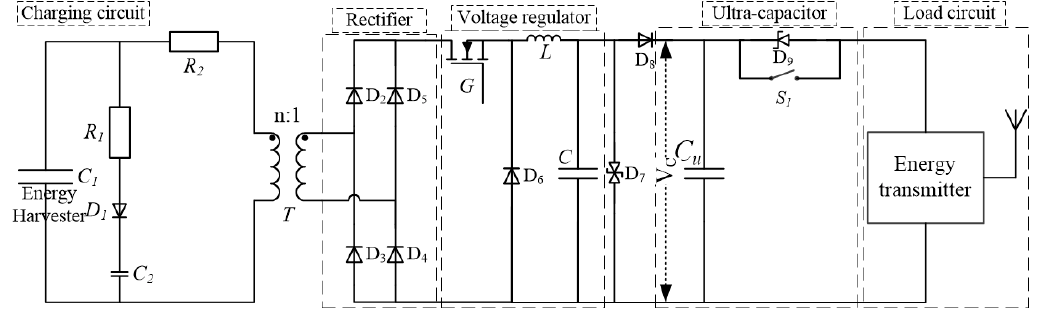
Figure 8. Voltage conversion Circuit.